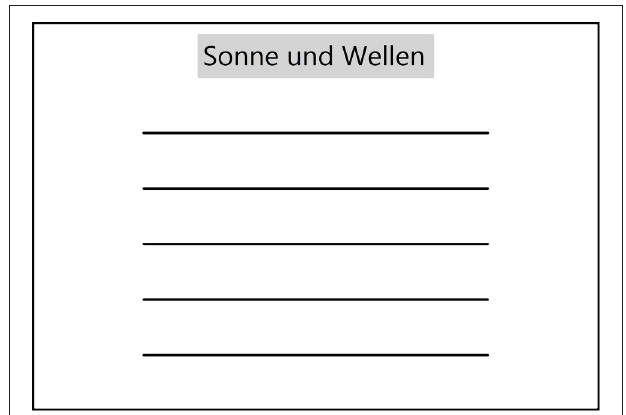
FIGURE 3 | The writing space for “Sonne und Wellen” (German, English “sun and waves”). Reprinted from Gerth et al. (2016) with permission from